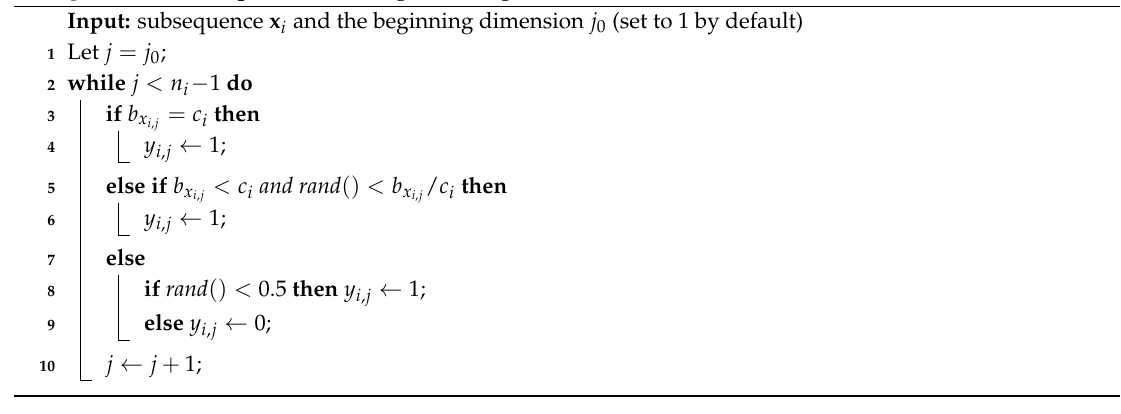
Algorithm 3: The procedure for generating the direction vector.